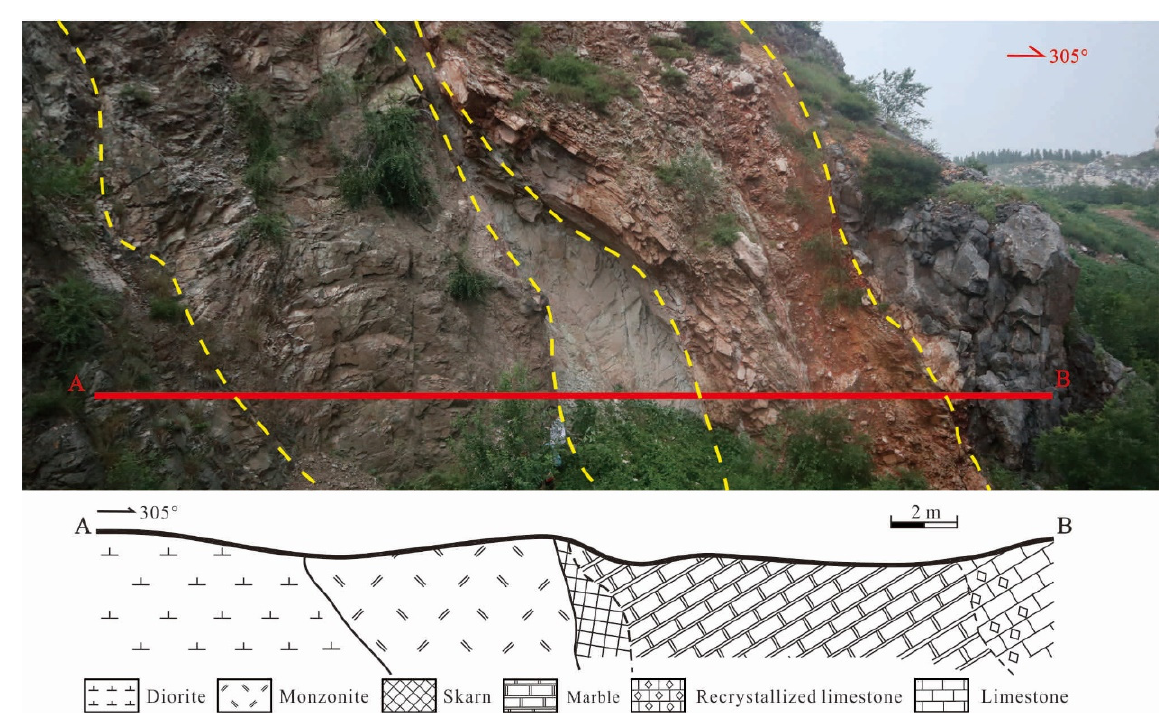
Figure 4. Schematic section view of the contact zone between the Jinling dioritic pluton and Ordo- vician carbonates, including marble, recrystallized limestone, and limestone. The yellow dashed line in the Figure 4 is the boundary of geological bodies.